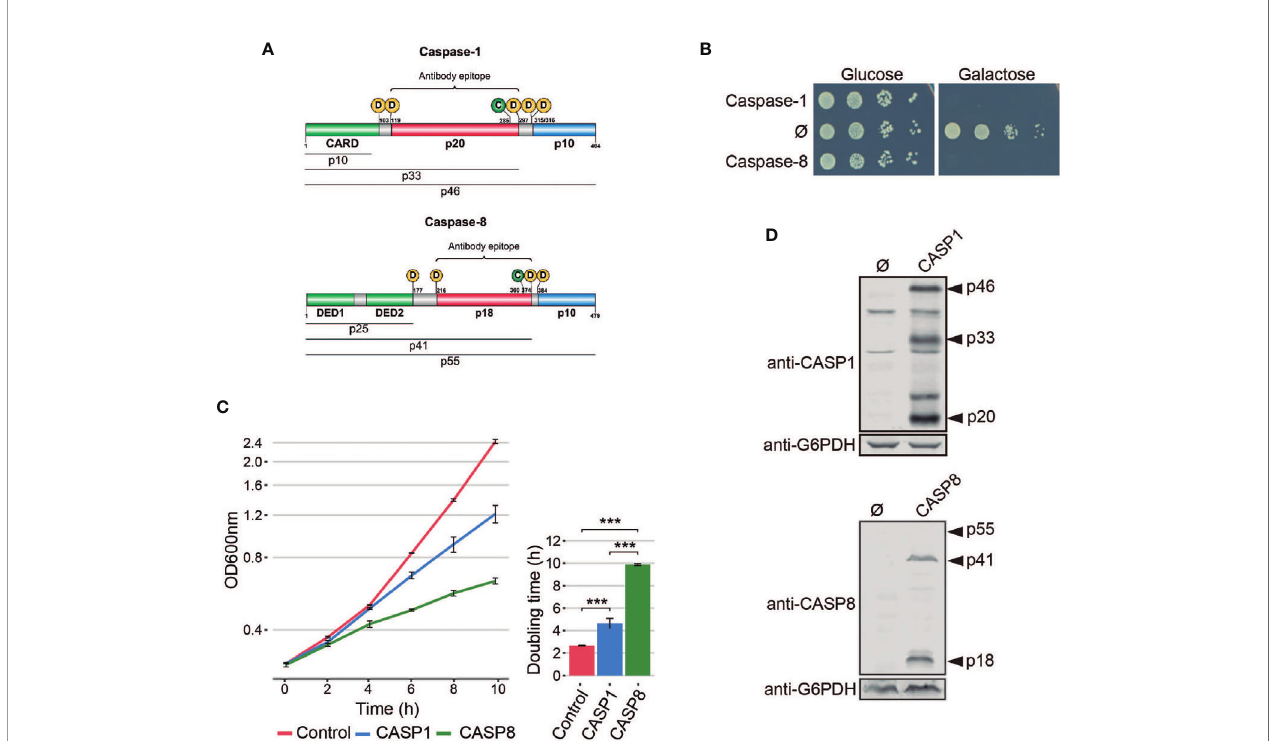
FIGURE 1 | Heterologous expression of human caspase-1 and caspase-8 inhibits S. cerevisiae cell growth. (A) Schematic representation of Caspase-1 and 8 depicting their respective DDs (green), long (red), and short (blue) catalytic subunits. Their potential cleavage products and their size, the autocleavage aspartic residues (D), the cysteine residue at the catalytic center (C), and the epitopes recognized by their respective antibodies are also indicated. (B) Spot growth assay of BY4741 strain bearing pAG413-Caspase-1 and pAG413-Caspase-8. pAG413 empty vector (Ø) was used as a negative control. Cells were cultured on SD (Glucose) and SG (Galactose) agar media for repression and induction of caspase-1 and caspase-8 expression, respectively. A representative assay from three different experiments with different transformant clones is shown. (C) Growth curves of cells bearing the same plasmids as in panel (B) performed in SG medium. Measures of OD 600 were taken each two hours throughout the exponential growth phase. Results are represented as OD 600 vs time in a semilogarithmic plot (left panel). Doubling times were determined by calculating the slope over the linear portion of the growth curve (right panel). Results correspond to the mean of three biological replicates performed on different transformants. Error bars represent SD. Asterisks (***) indicate a p-value < 0.01 by the Tukey ’ s HSD test. (D) Immunoblots showing the expression of caspase-1 (upper panel) and caspase-8 (lower panel) in yeast lysates of cells bearing the same plasmids as in (B) after 5 h induction in SG medium. Membranes were hybridized with anti-caspase-1 and anti – caspase-8 antibodies. Anti-G6PDH antibody was used as loading control. A representative blot from three different experiments with different transformants is